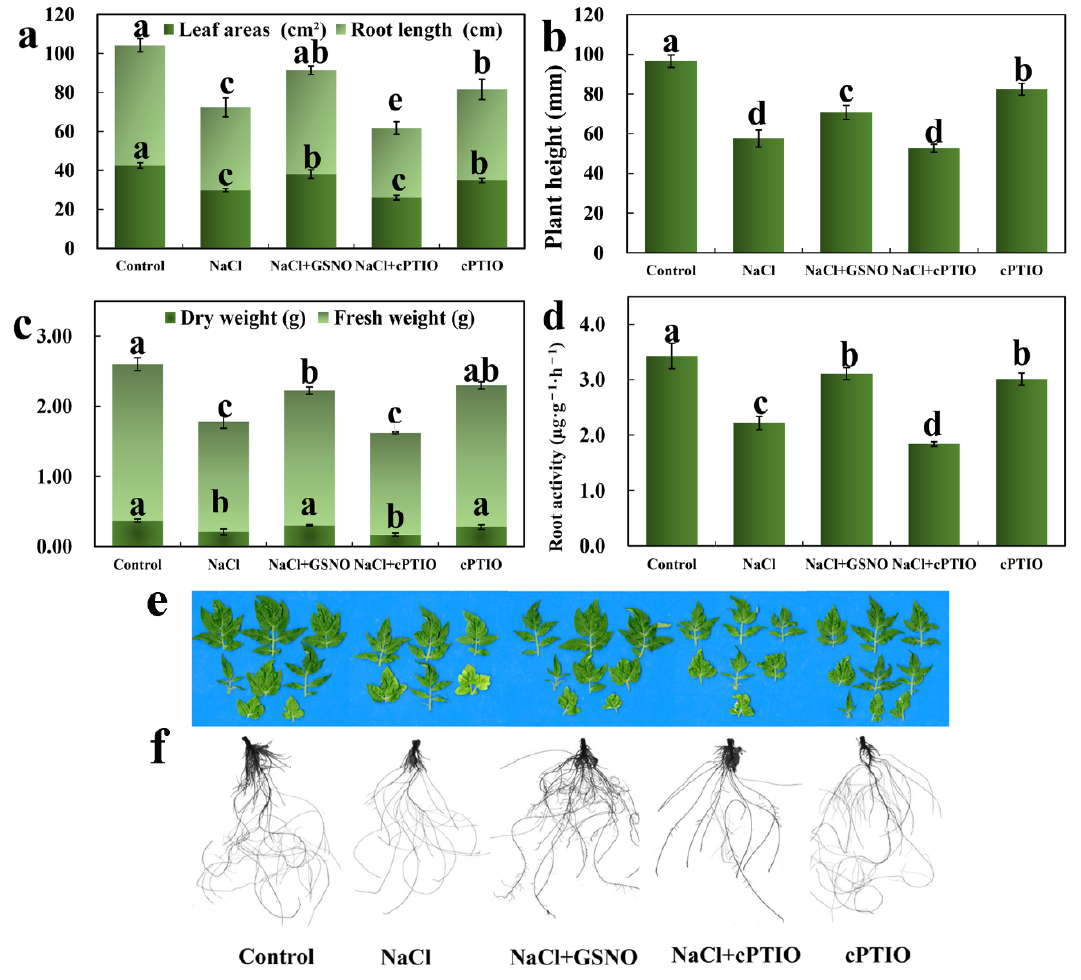
Figure 1. Effects of GSNO on phenotypic and physiological indexes of tomato seedlings during salt stress. ( a ) Leaf area and total root length. ( b ) Plant height. ( c ) Dry weight and fresh weight of the aboveground part of the plant. ( d ) Root activity. ( e , f ) Photographs were taken after 7 days of different treatments. The values (means ± SE) are the averages of three independent experiments ( n = 15). Different letters mean significant difference by Duncan’s multiple range test ( p < 0.05).